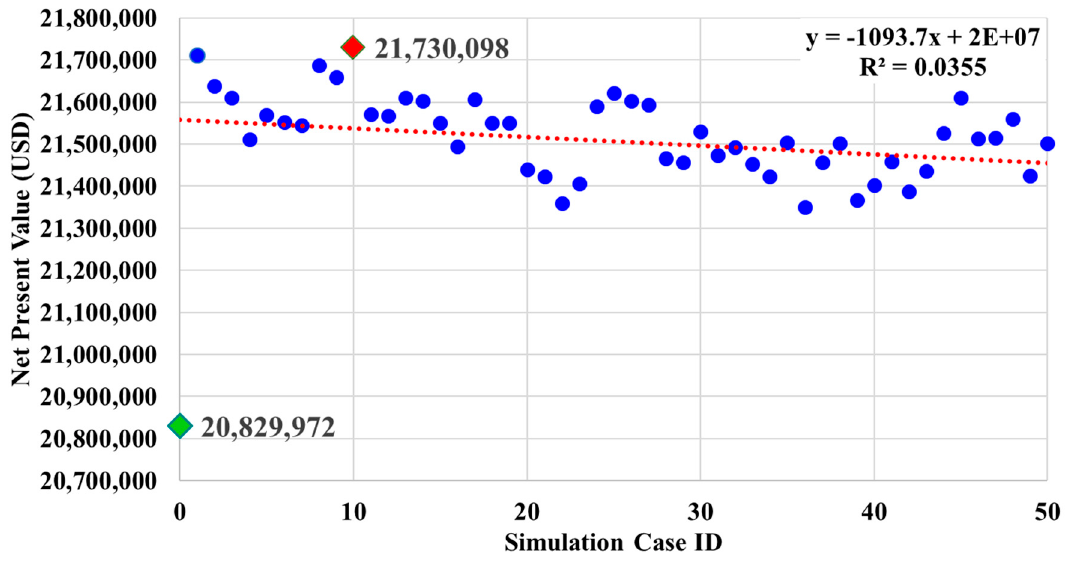
Figure 4. OCD’s optimization results (short-term).